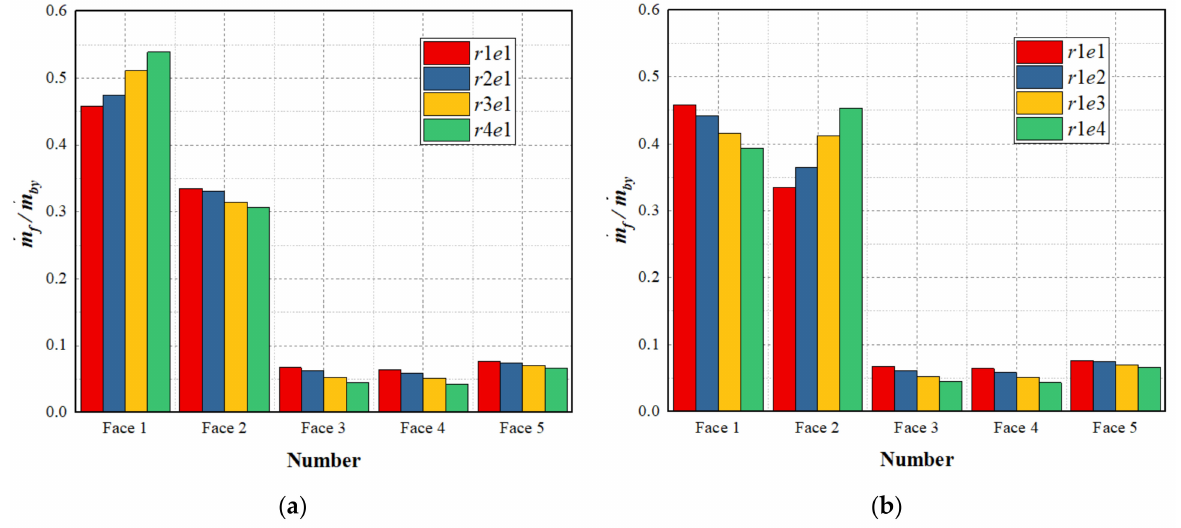
Figure 8. Distribution of bypass flow under cases with different cooling flow path structure parameters: ( a ) heat shield inlet height r ; ( b ) afterburner annulus height e